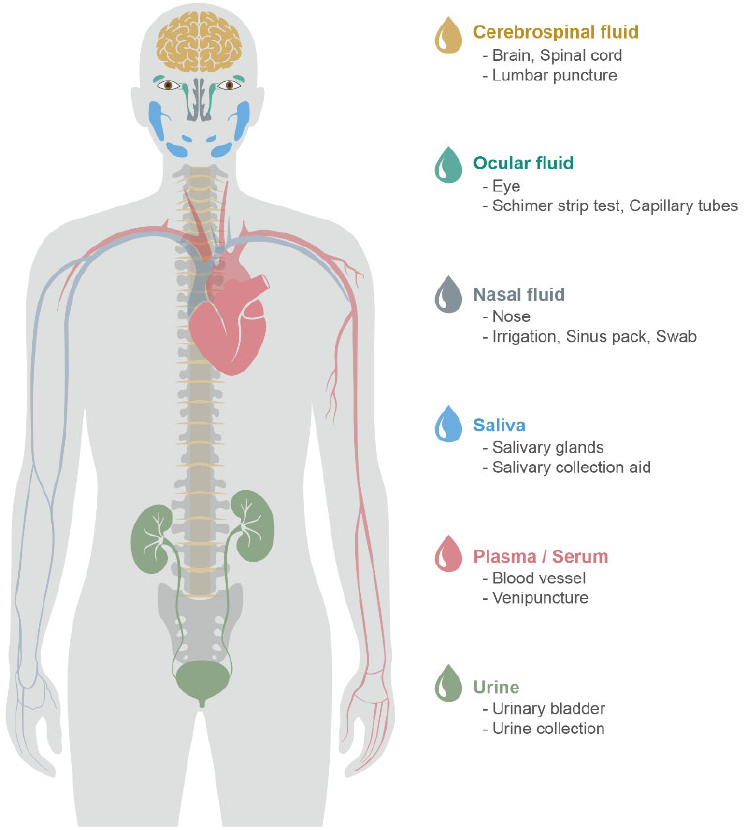
Figure 1. Body fluids for the identification of potential biomarkers for AD. Sample type, organ, sam ‐ pling method (from